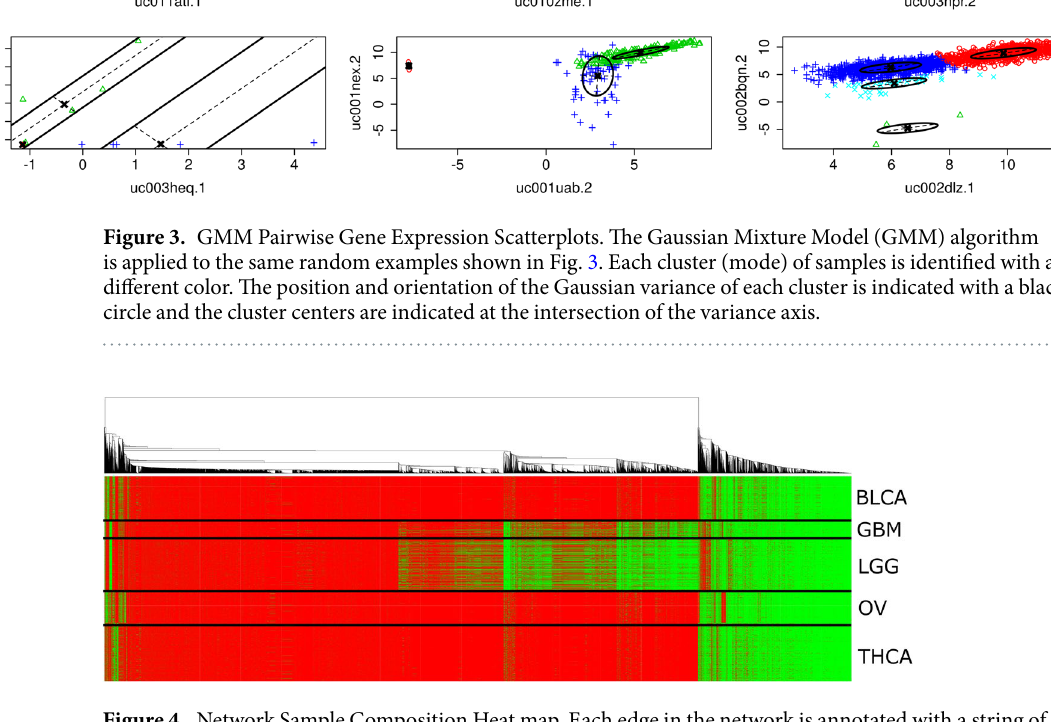
Figure 4. Network Sample Composition Heat map. Each edge in the network is annotated with a string of 1’s and 0’s, referred to as a sample string. For the human cancer network, each string consists of 2016 1’s and 0’s with a 1 indicating that the sample is present within the cluster that formed the edge, and a 0 indicating it is not included. Hierarchical clustering using the heat map function of the R statistical package was used to order edges by similarity of their sample strings and generate this figure. Here, red indicates the presence of a 0 in the sample string and green indicates the presence of a 1. Each column of the heat map represents an individual edge in the network. Samples represent rows in the heat map and are grouped according to cancer types (i.e. BLCA, GBM, LGG, OV and THCA). An artificial black line was added to distinguish between “lanes” of each cancer